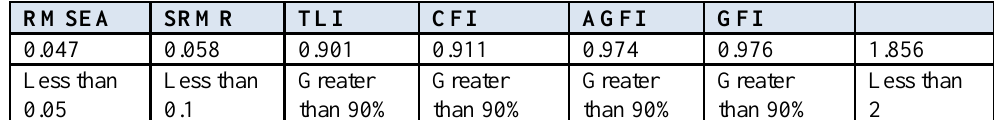
Table 6. Characteristics of goodness of fit of